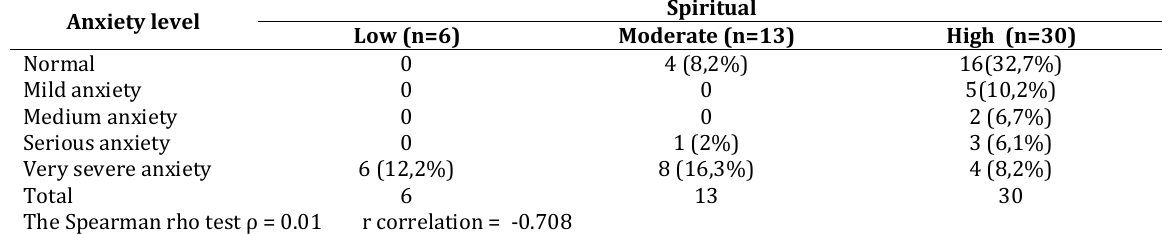
The Spearman rho test ρ =